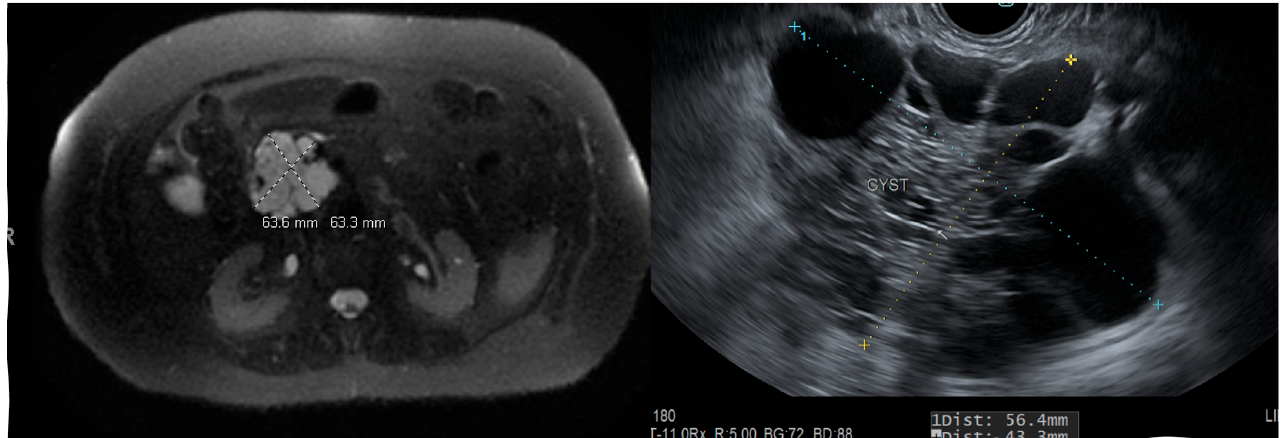
Figure 5. MRI and endoscopic ultrasound demonstrating a serous cystadenoma occupying the head and neck of pancreas.